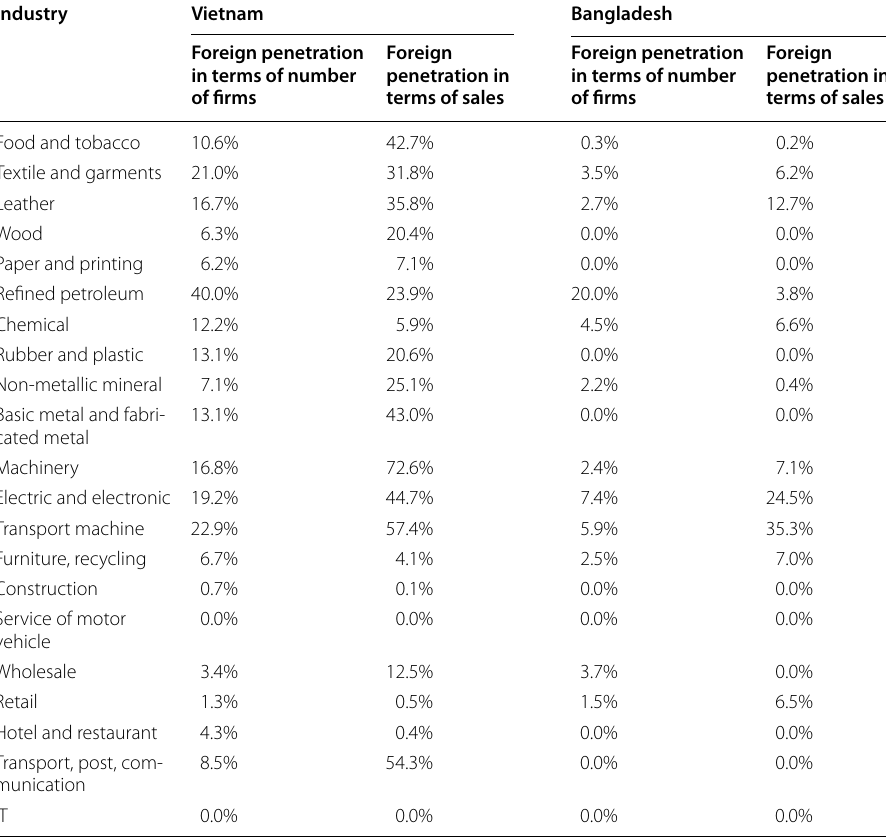
Table 5 Foreign penetration Source: Author’s calculation based on the World Bank’s Enterprise Survey data (for Vietnam panel data of 2005, 2009, and 2015; for Bangladesh panel data of 2007, 2011, and